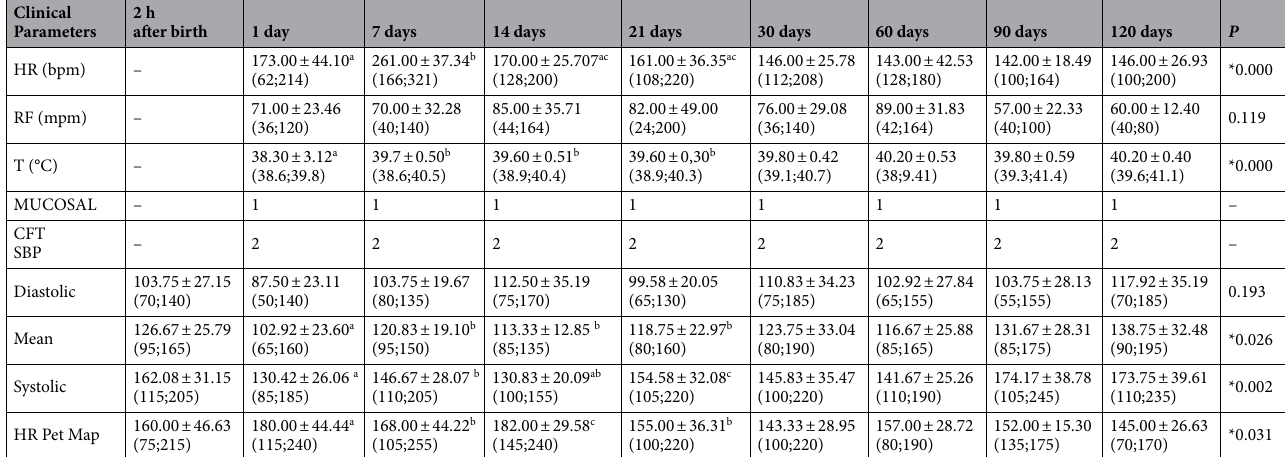
Table 1. Clinical examination parameters (mean, standard deviation, minimum, and maximum) in lambs from 24 h after birth until 120 days of age. Kolmogorov ‒ Smirnov normality test; comparison between Friedmann’s test moments; * significance: p < 0.05; HR- heart rate; RF- respiratory frequency; T- rectal temperature; CFT- capillary filling time; SBP- systolic blood pressure; ab letters overwritten on the same line indicate a significant difference between specific moments (24 h after birth up to 21 days of